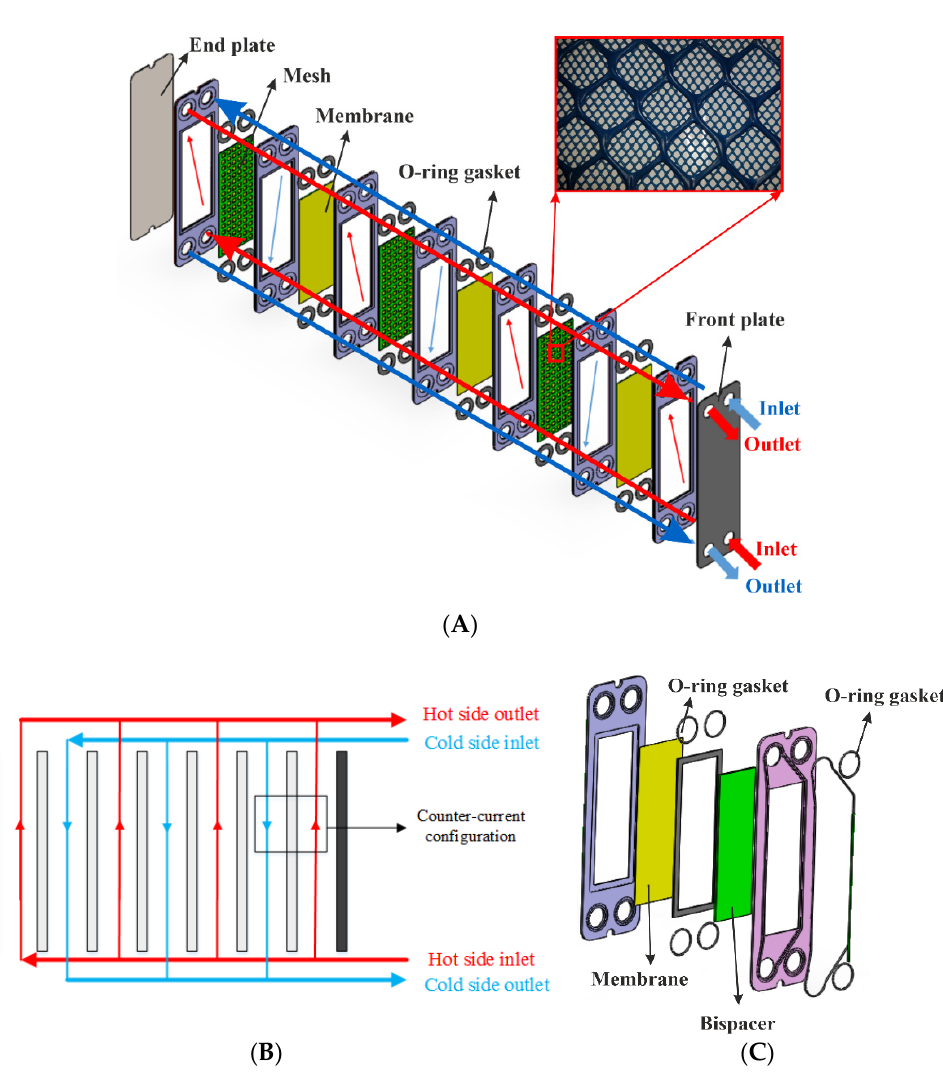
Figure 2. The schematic of multi-staged direct contact membrane distillation of the present study: ( A ) 3D schematic, ( B ) fluid flow schematic, ( C ) the Schematic of the position of the O-ring gasket.